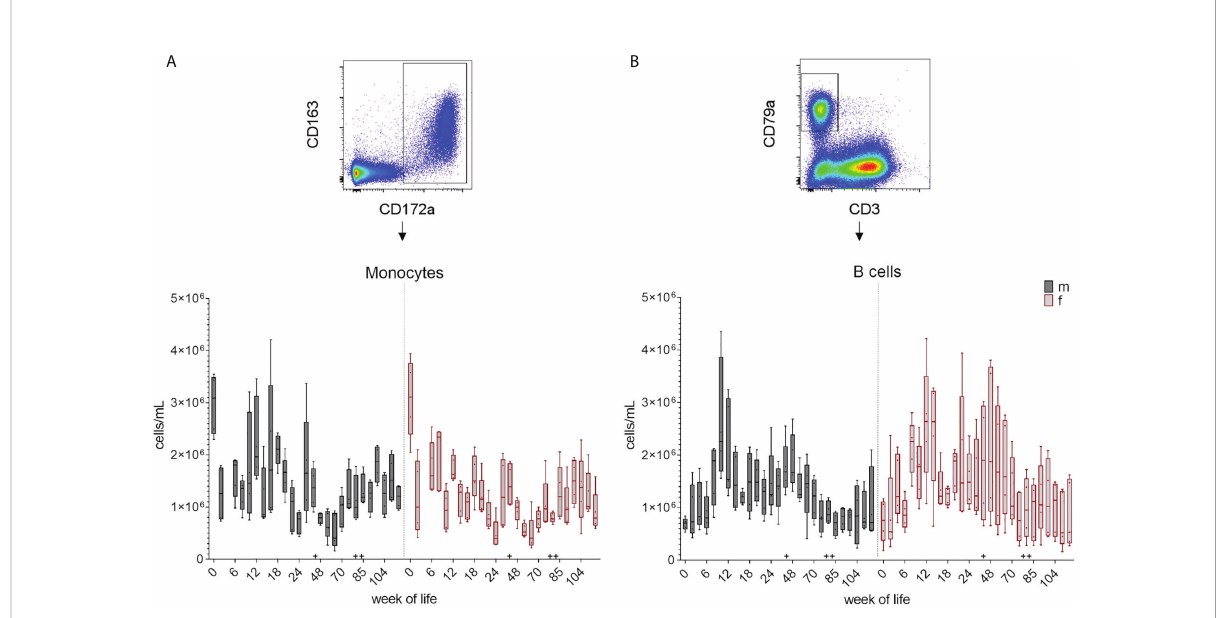
FIGURE 3 Total number of monocytes and B cells over the study period of 126 weeks. Determination of total cell counts was combined with FCM analyses. A representative EGM (male, 18 weeks of age) was chosen to show the characterization of the subsets. Sexes are represented by black (male) and red colors (female). (A) Monocytes were identi fi ed using CD172a + co-expressed with CD163 + . (B) Number of B cells were determined by their CD3 - CD79a + phenotype. + marks the fi rst bleeding time point after transfer and vaccination, ++ marks the fi rst bleeding time point after booster